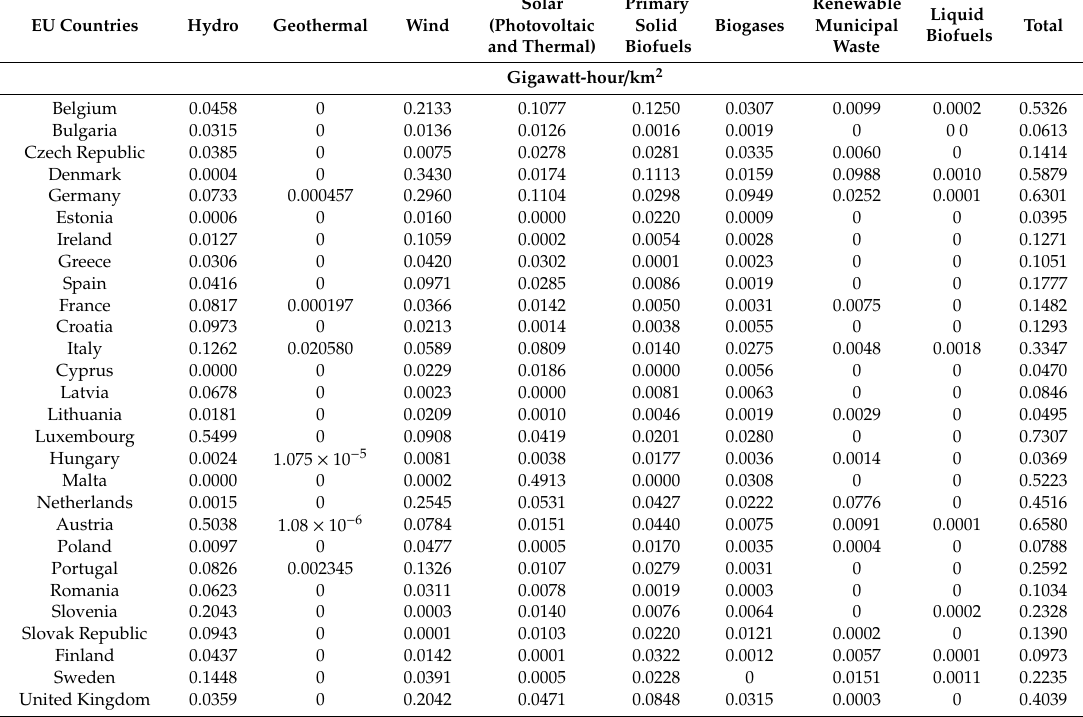
Table 4. Structure of energy production from renewable energy sources per 1 km 2 of area of individual EU countries in 2017 (own study based on data from [37]).